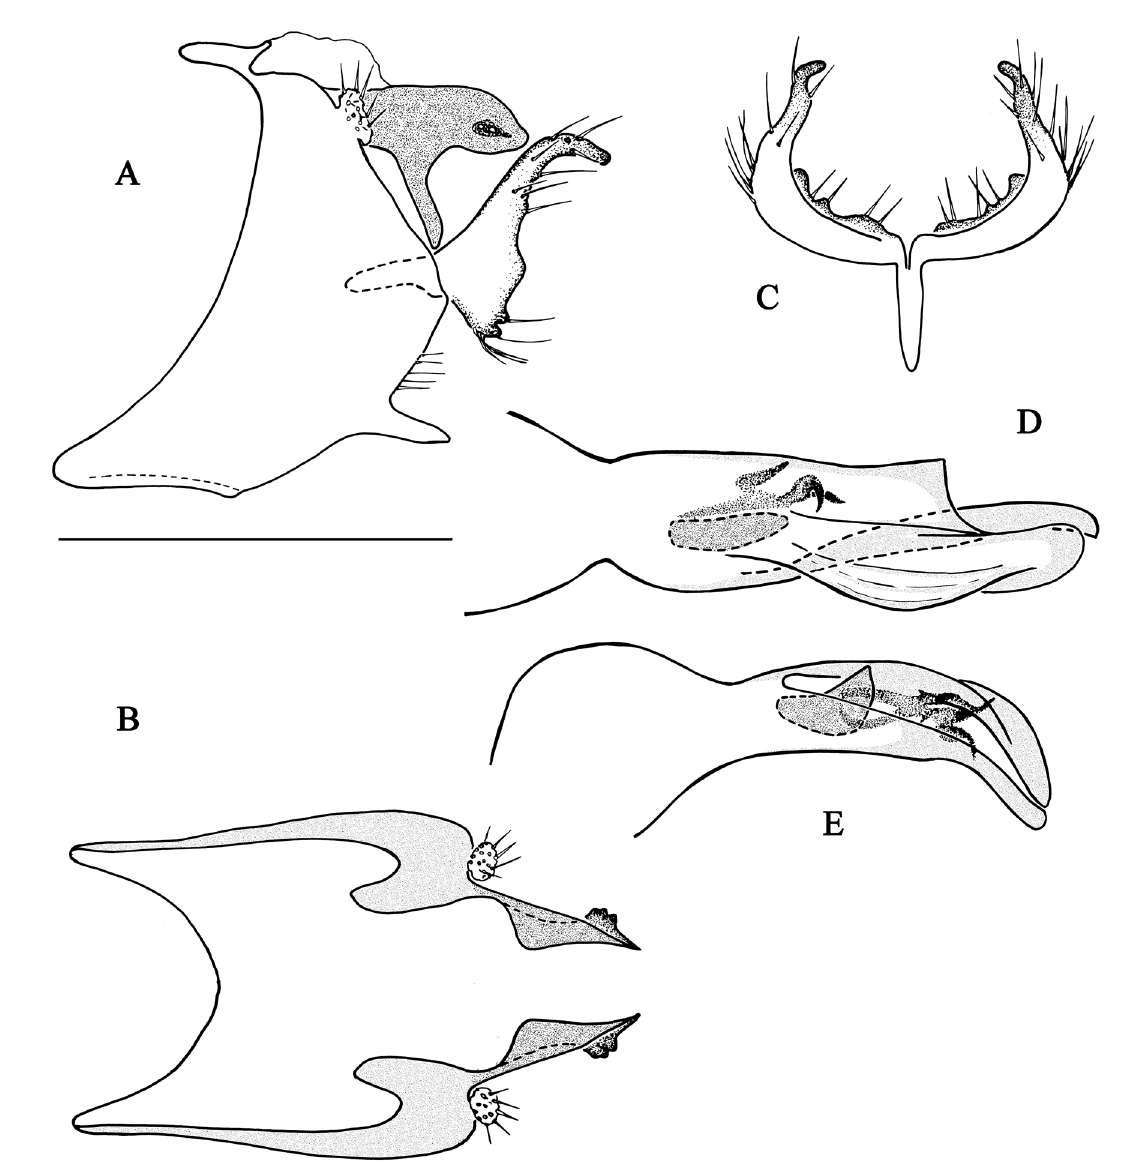
Fig. 8. Chimarra gensonae sp. nov. A–B . Abdominal segments IX and X. A . Lateral view. B . Dorsal view. C . Inferior appendages, dorsal view. D–E . Phallic apparatus. D . Dorsal view. E . Lateral view. Scale bar = 0.5